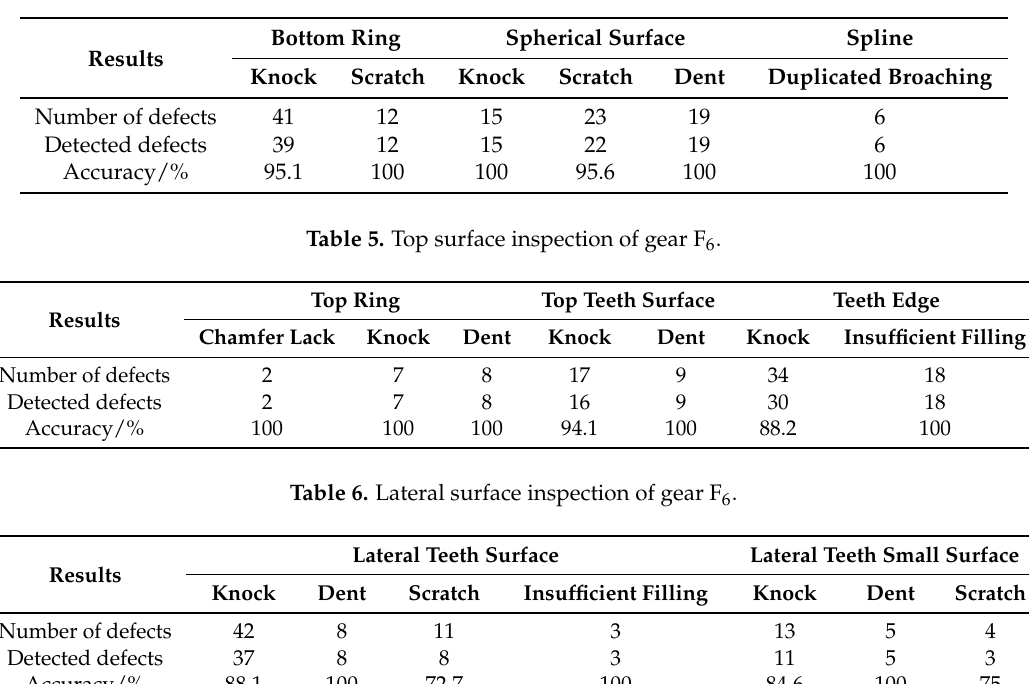
Table 4. Bottom surface inspection of gear A 4 .